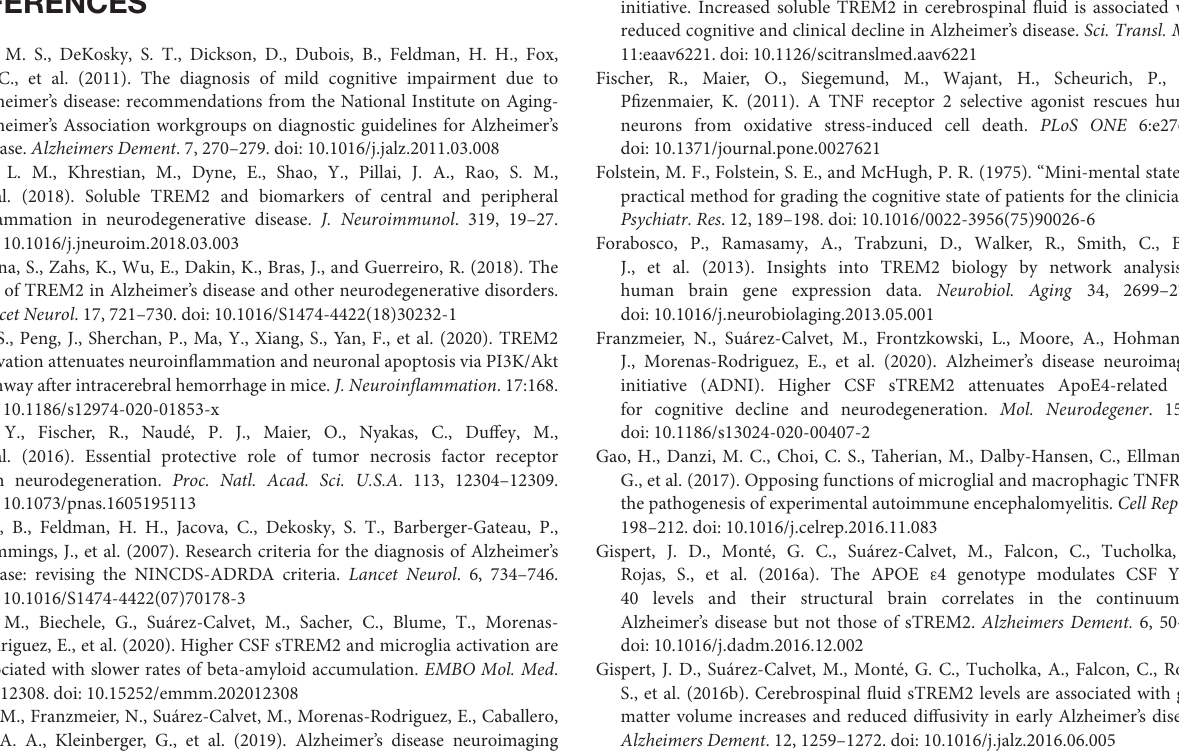
Supplementary Table 3 | Key results of the general linear model with CSF A β 42, t-tau, and p-tau as the dependent variables among cognitively normal A + T + participants from the Alzheimer’s Disease Neuroimaging Initiative cohort. Supplementary Table 4 | Key results of the general linear model with CSF A β 42, t-tau, and p-tau as the dependent variables among cognitively normal A + T– participants from the Alzheimer’s Disease Neuroimaging Initiative cohort. Supplementary Table 5 | Key results of the general linear model results with CSF A β 42, t-tau, and p-tau as the dependent variables among cognitively normal A– T + participants from the Alzheimer’s Disease Neuroimaging Initiative cohort. Supplementary Table 6 | Key results of the general linear model results with CSF A β 42, t-tau, and p-tau as the dependent variables among cognitively normal A– T– participants from the Alzheimer’s Disease Neuroimaging Initiative cohort. Supplementary Table 7 | Key results of the linear mixed-effects regression model with CDR-SB as the dependent variable among A + T + cognitively normal participants from the Alzheimer’s Disease Neuroimaging Initiative cohort (Model 3).